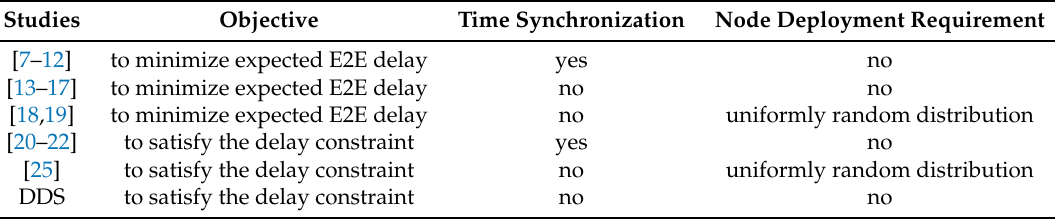
Table 1. Comparison table between our proposed duty-cycle scheduling (DDS) and existing studies.